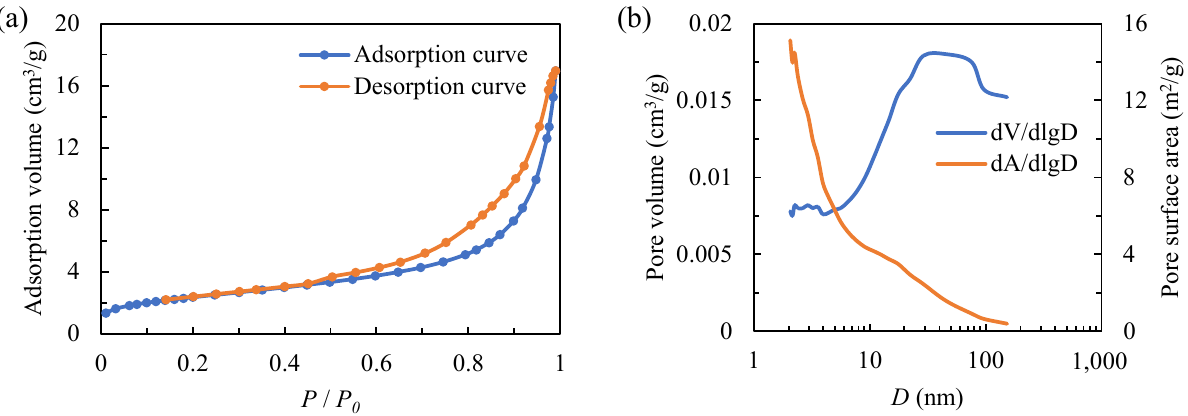
Figure 2. ( a ) Adsorption–desorption curve and ( b ) pore size distribution characteristics of experi- mental samples.